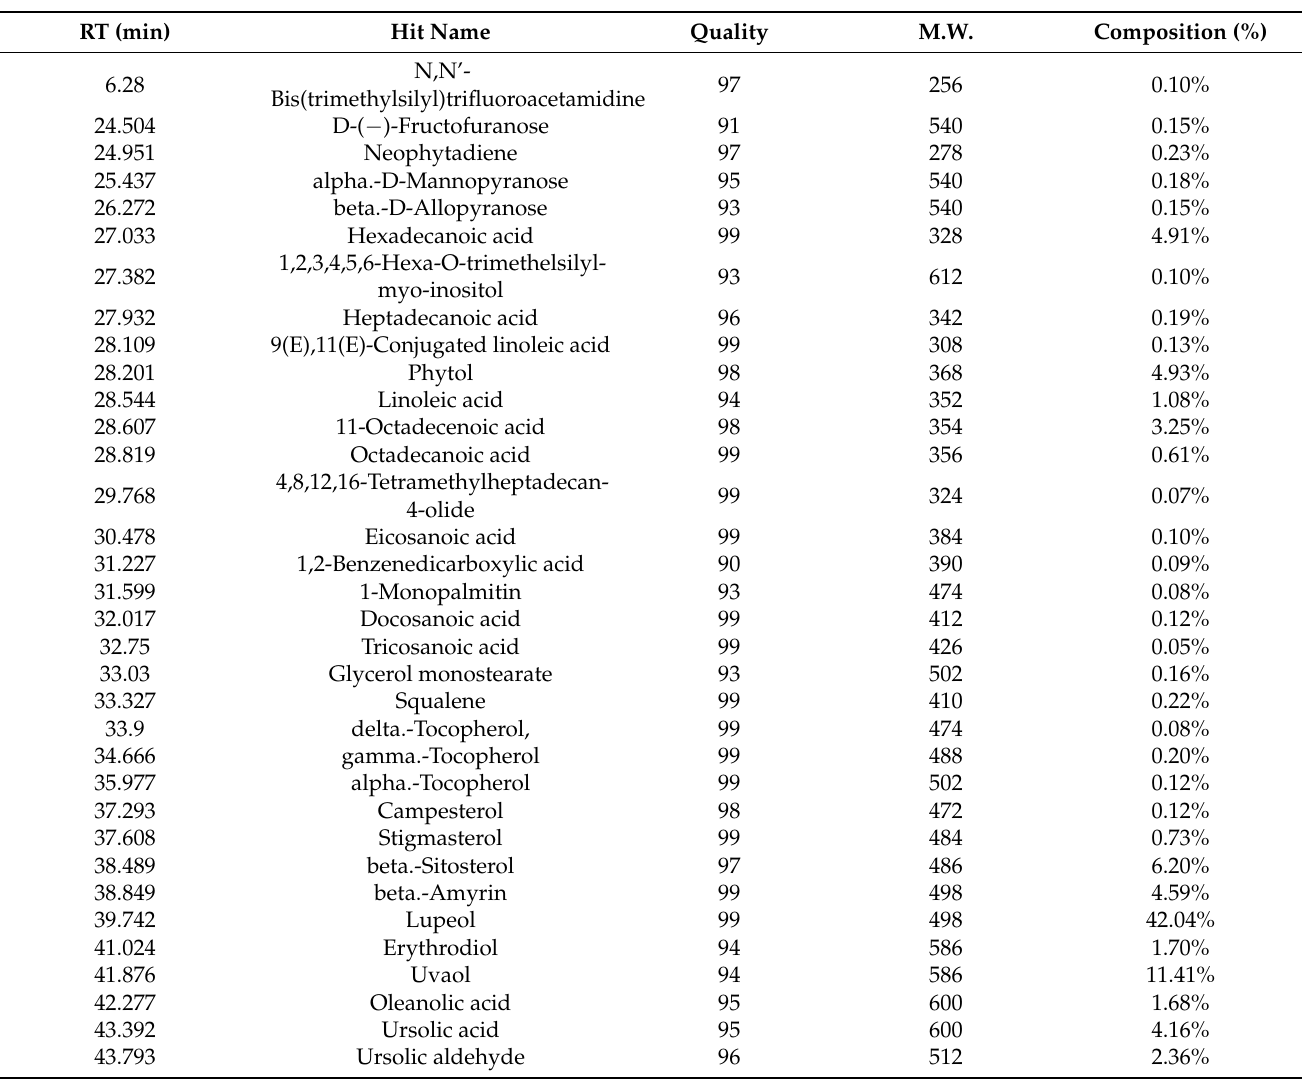
Table 6. GC-MS analysis of hexane extract from IW leaf.